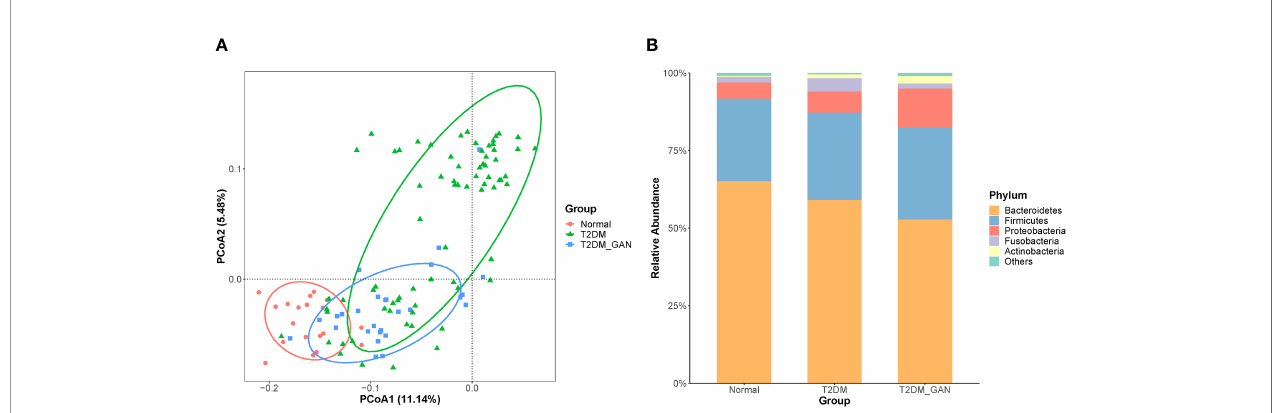
FIGURE 2 | T2DM_GAN induce signi fi cant changes in the gut microbiota. (A) Unconstrained PCoA (for principal coordinates PCo1 and PCo2) with unweighted UniFrac distance shows that gut microbiota of 119 subjects formed three distinct clusters, which separate along the third coordinate axis ( p = 0.001, mrpp). Ellipses cover 80% of the data for each group. (B) Distribution map of relative abundance of each group at the top 5